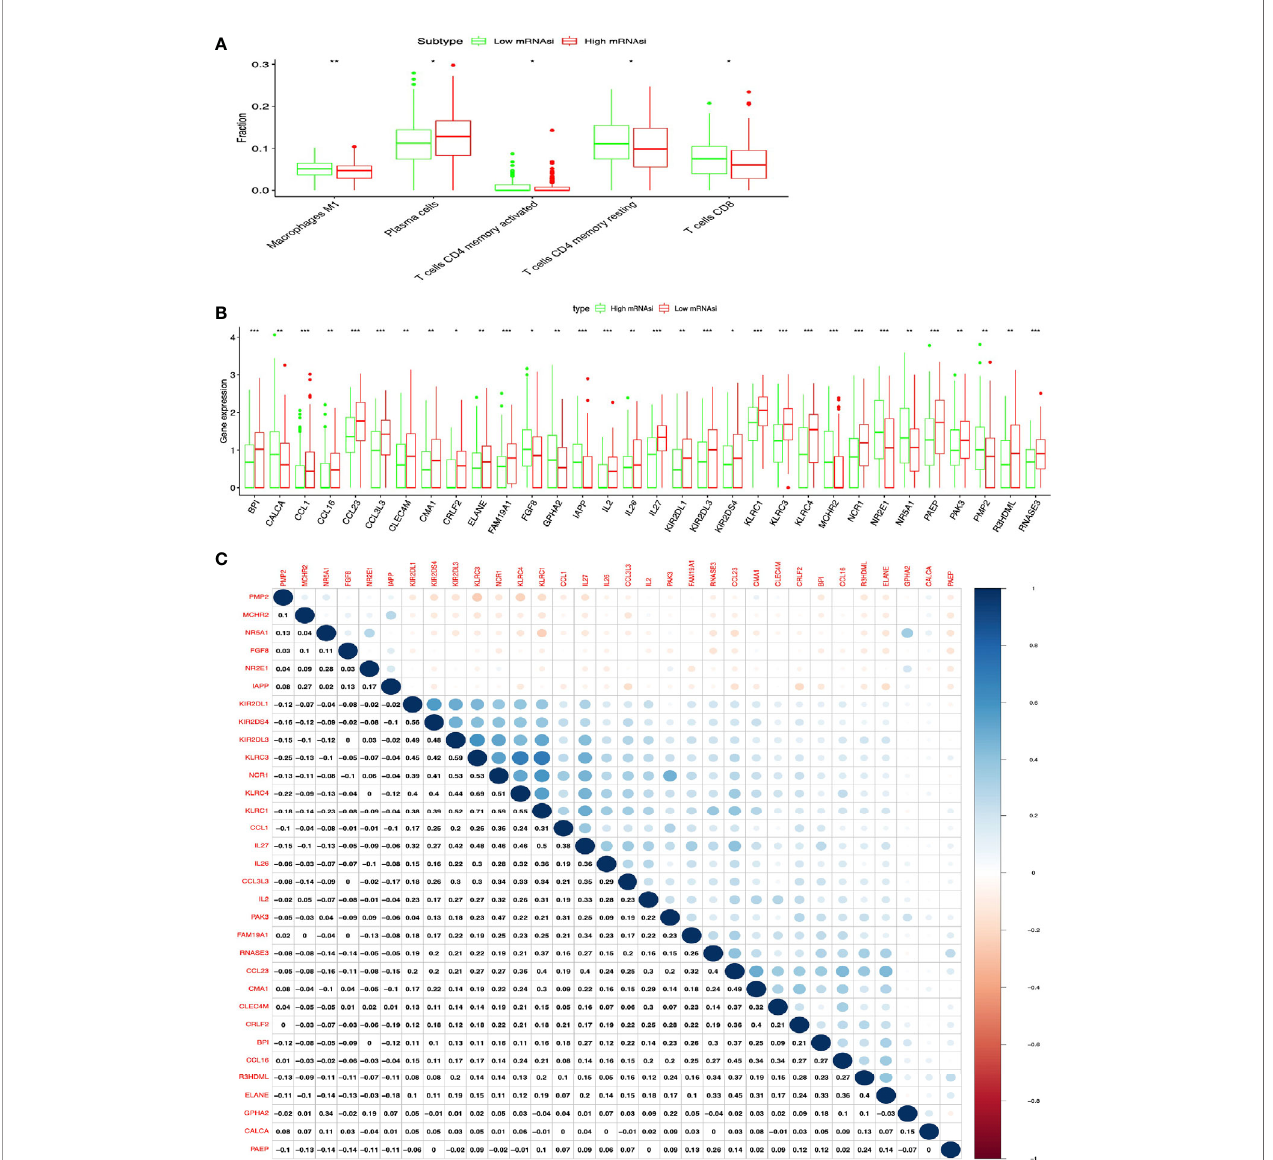
FIGURE 4 | Identi fi cation of DEIRGs between higher- and lower-mRNAsi groups in LUSC. (A) The distribution of immune cells between higher- and lower-mRNAsi groups. (B) DEIRGs between higher- and lower-mRNAsi groups. (C) The correlation between DEIRGs. *p < 0.05, **p < 0.01, ***p < 0.001.